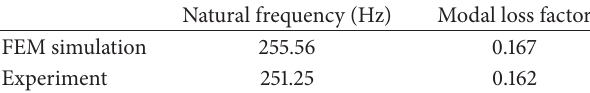
Table 2: Comparison of FEM simulation and